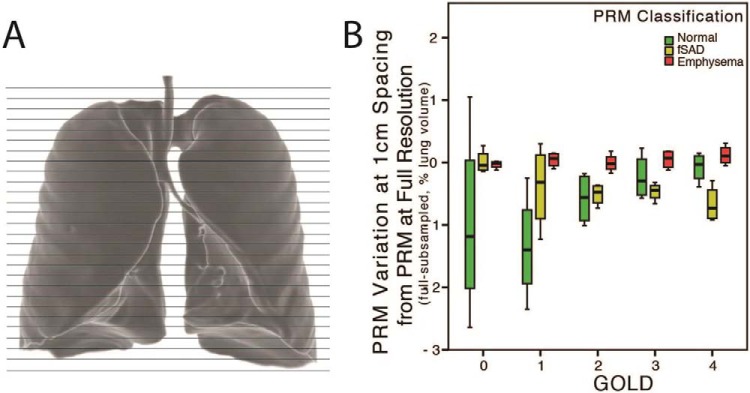
Impact of 10 mm slice intervals on PRM. Spacing between slices is illustrated in (A). PRM differences from full resolution are presented per GOLD stage for a standard reconstruction kernel (B). Variations in PRMNormal are greater for mild COPD. PRMfSAD varies the most in mild COPD, whereas similar but small variations in all 3 metrics are seen in moderate-to-severe COPD. The lines on the box plot are as follows: The lines on the box plot are as follows: center line, median; bottom and top boxes, 25% and 75% quantiles, respectively; bottom and top bars, 1.5 times the box size or the minimum value if no values fall in that range. Note for normally distributed data approximately 95% of the data are expected to lie between the distal fences (n = 4 per GOLD stage).